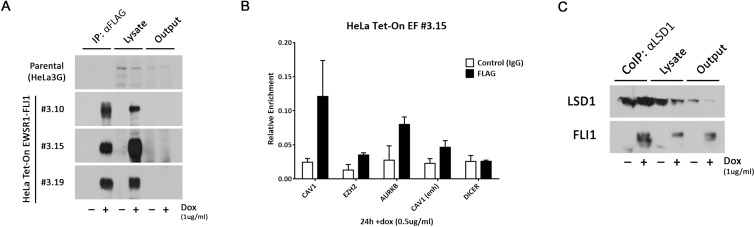
Ectopic EWSR1-FLI1 interacts with specific DNA and protein-binding sites.A. EWSR1-FLI1 immunoprecipitation using anti-FLAG antibody in parental HeLa3G cells (control) and two different clones (HeLa Tet-On EF #3.10 and #3.15) in the presence or absence of doxycycline. B. Binding of EWSR1-FLI1 to the CAV1 enhancer and the promoters of the CAV1, EZH2 and AURKB genes. qPCR analysis of EWSR1-FLI1 ChIP signals for HeLa Tet-On EF #3.15 clone. C. Co-immunoprecipitation of EWSR1-FLI1 3×FLAG C-terminal and LSD1 protein in HeLa Tet-On EF #3.15 clone.